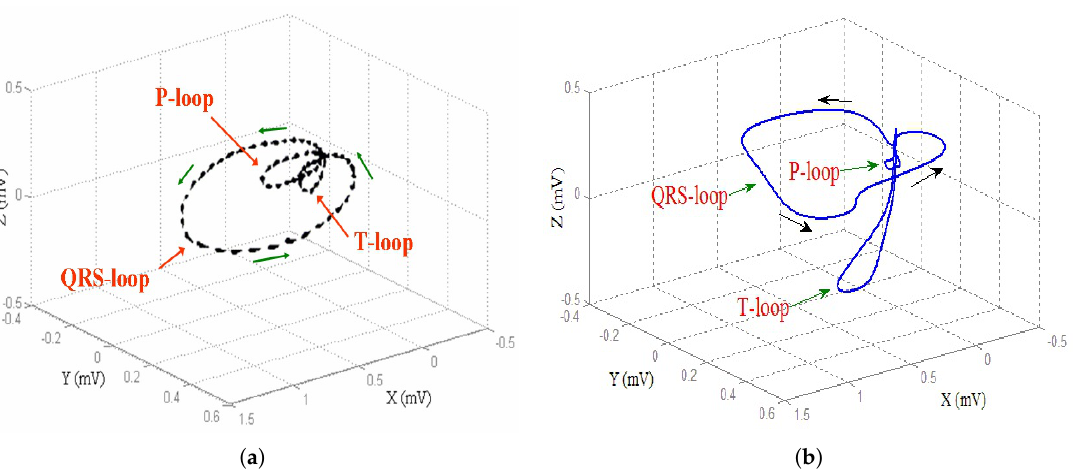
Figure 2. ( a ) A typical vector cardiogram (VCG) loop for a normal cardiac cycle. ( b ) A typical VCG loop characterized by a nodal rhythm